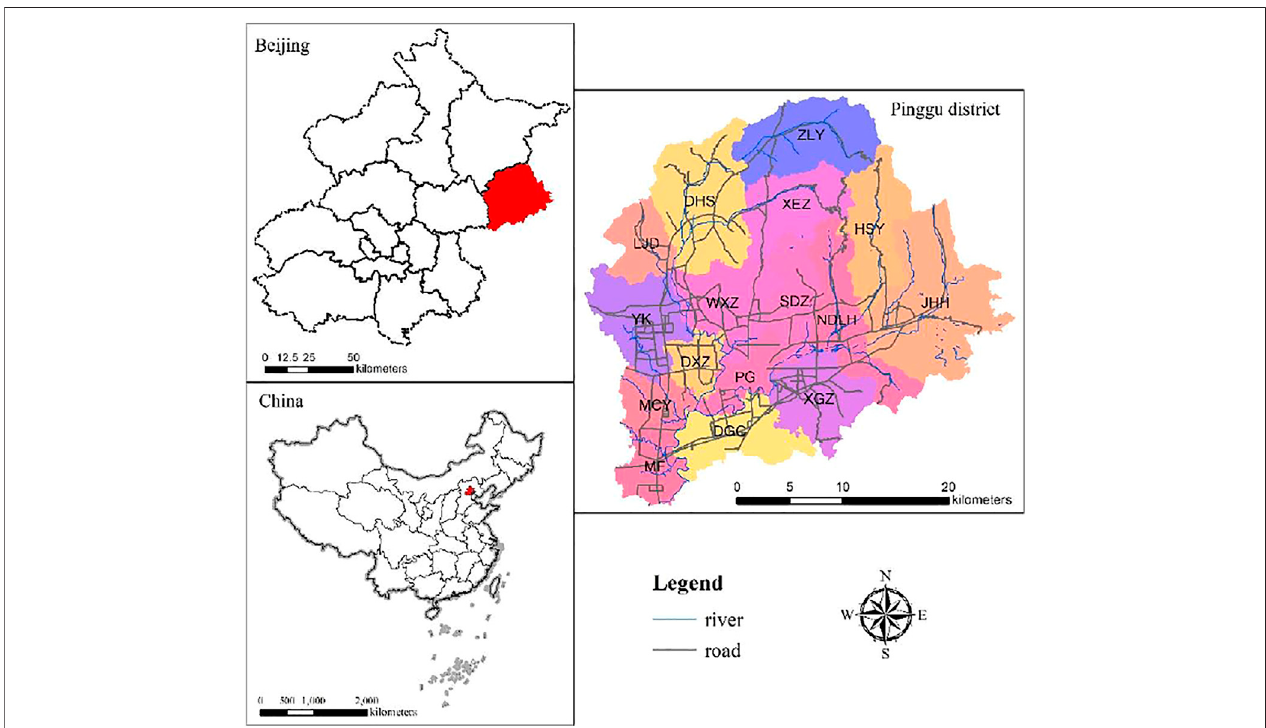
FIGURE 1 | Location of Pinggu, Beijing, China (PG is Pinggu Town, the central town of Pinggu District, which is not the research object of this paper).